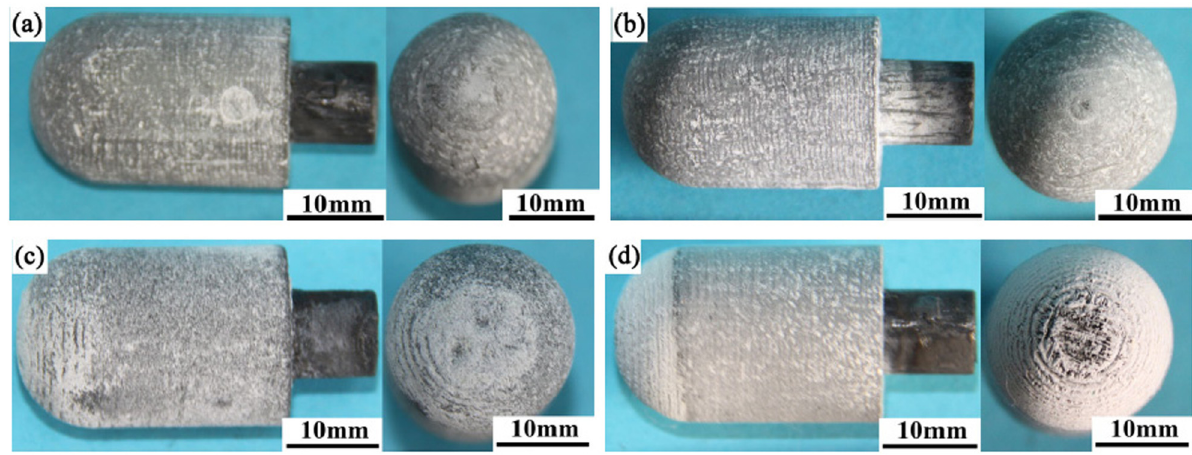
Figure 7: Macroscopic images of C/SiC – HfC composite after ablation [ 110 ] : ( a ) 3.5 MW · m − 2 ; ( b ) 3.5 MW · m − 2 ; ( c ) 4.5 MW · m − 2 ; ( d ) 5.1 MW · m − 2